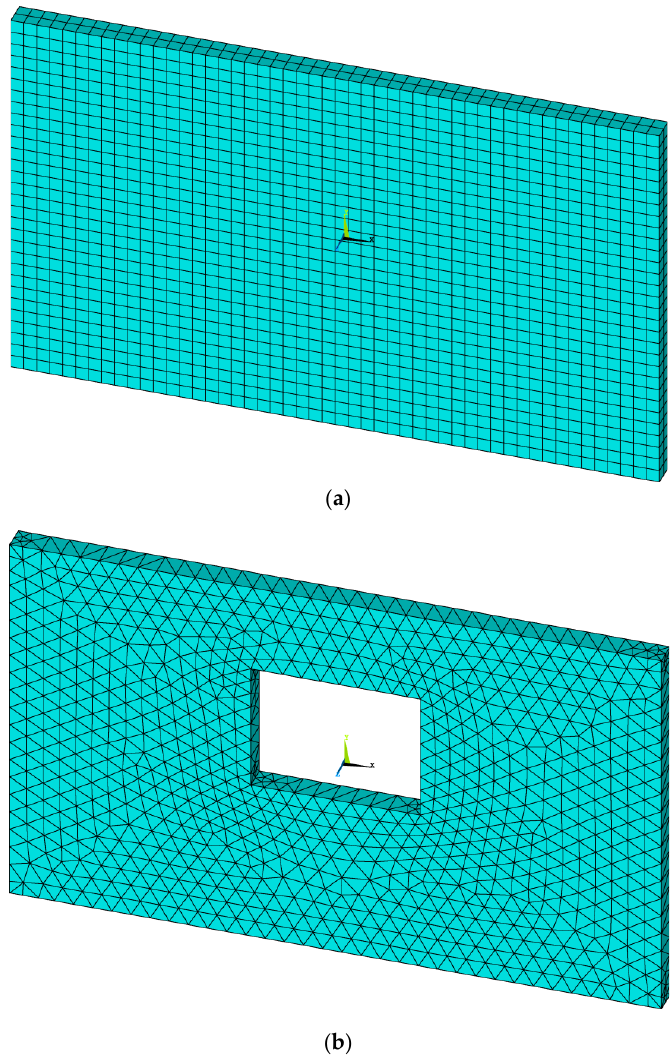
Figure 11. Model layout: ( a ) W1A; ( b ) W1B wall specimens.